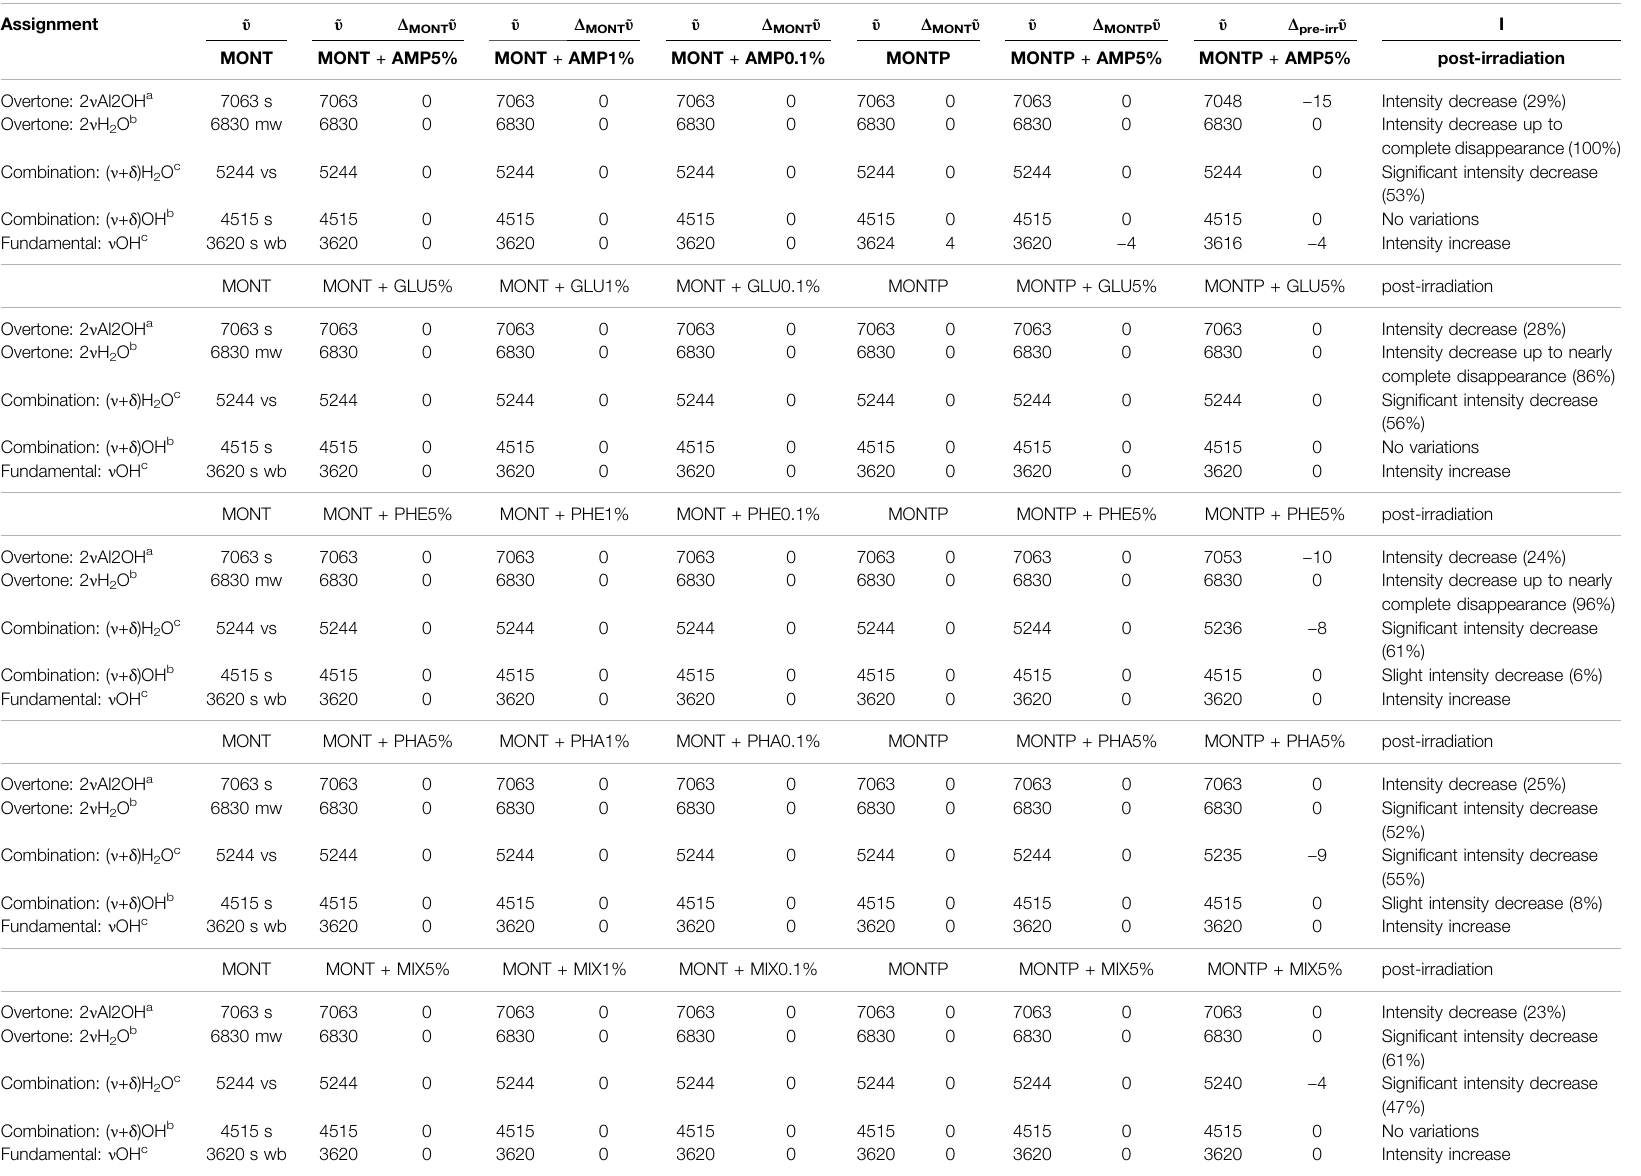
TABLE 2 | Changes of montmorillonite NIR features due to molecular adsorption at different concentrations (5, 1 and 0.1 wt%), presence of 1 wt% of magnesium perchlorate and 70 min of UV irradiation.